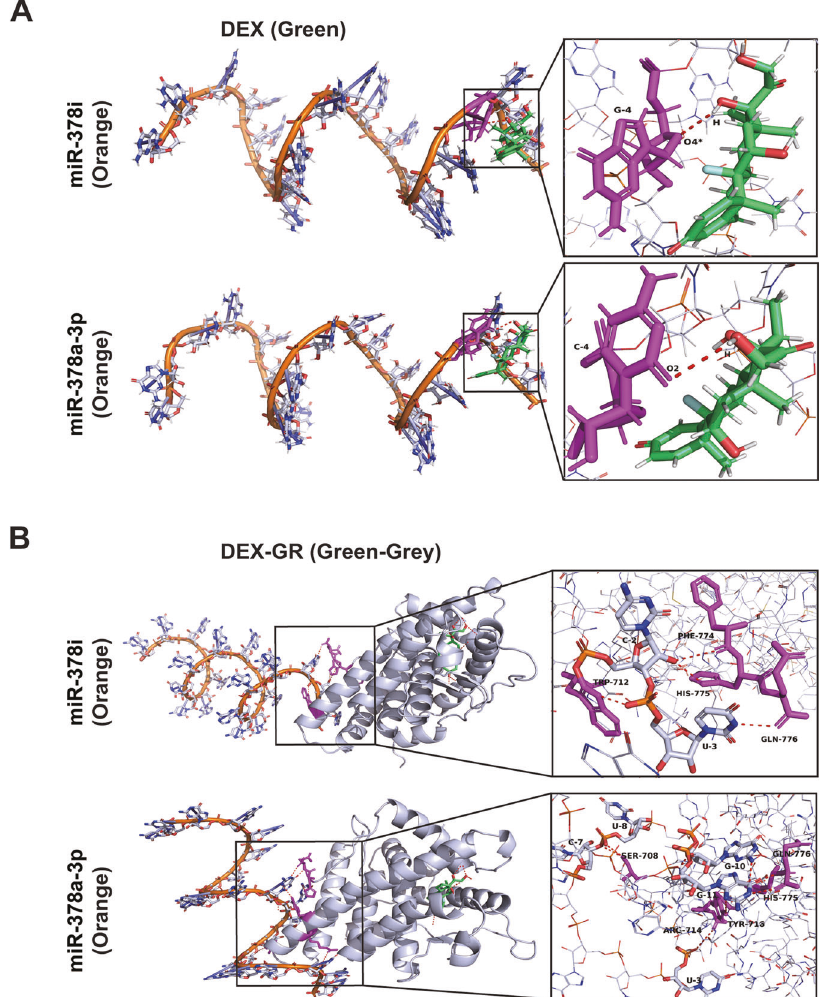
Fig. 7 Bioinformatic molecular docking simulation predicts binding of miR-378 to DEX and GR. A Molecular docking simulation of miR- 378i and miR-378-3p to DEX was performed using YASARA Macro software, and the results were visualized by PyMOL 2.5 software. Green: DEX; Orange: miR-378; Violet: Binding sites of miR-378i and miR-378a-3p. Oxygen atom 4: (O4); Guanine 4: (G-4), H atom: (H); Oxygen atom 2: (O2); Cytosine 4: (C-4). Hydrogen bonds are marked by dotted lines. B Interactions between DEX-GR complexes were calculated by the use of the online ZDOCK server, visualized by PyMOL 2.5 and optimized by YASARA Macro software. The obtained model of the DEX-GR complex (green ‒ gray) was used for detection of putative binding sites with miR-378 (orange) by the use of the ZDOCK server and visualization by PyMOL software. Hydrogen bonds are marked by dotted lines. G guanine, C cytosine, U uracil, O oxygen atom, TRP tryptophan, HIS histidine, PHE phenylalanine, GLN glutamine, SER serine, AGR arginine, TYR